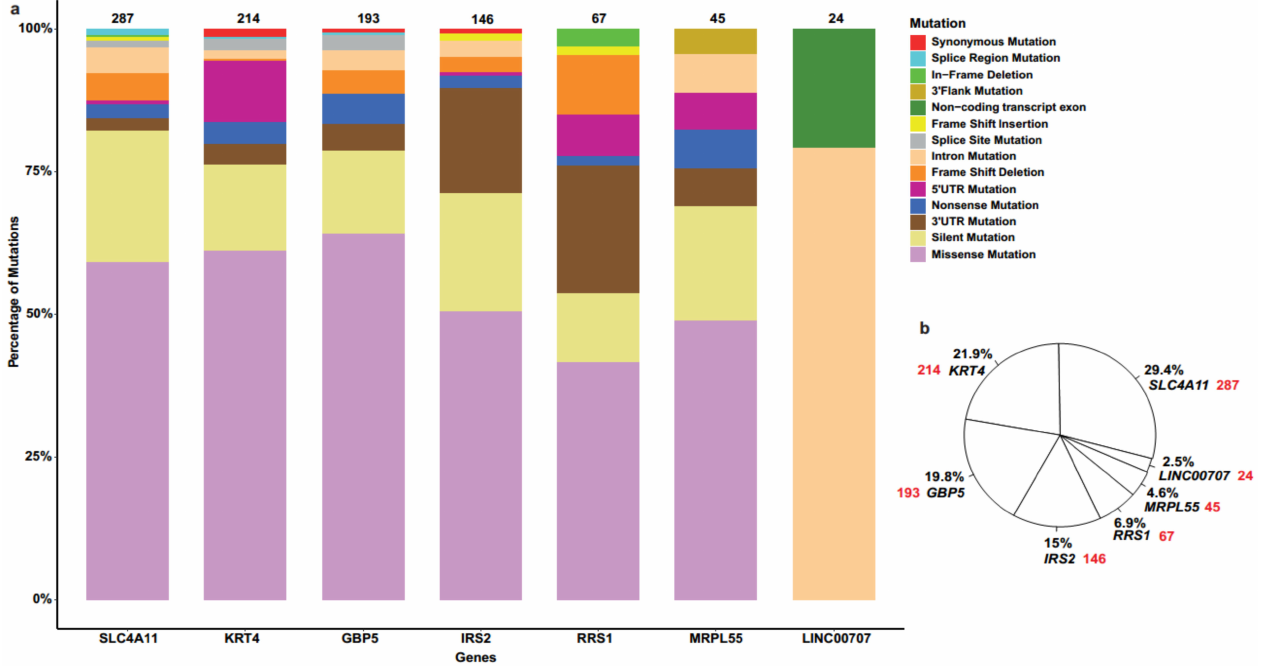
Figure 2. ( a ) Bar plot representing types of SNPs/mutations associated with seven biomarkers in human cancers. ( b ) Pie chart demonstrating the percentage distribution of 976 SNPs for 7 biomarkers in human cancers, where red colour represents the number of mutations in each